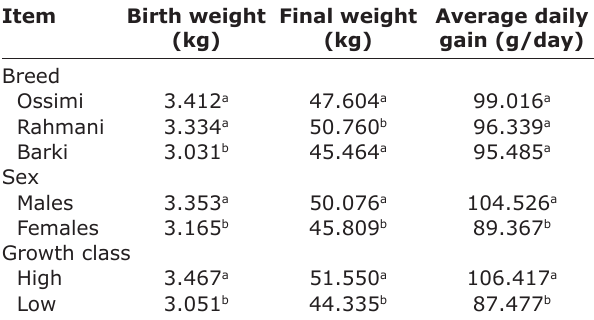
Table-2: Least squares means of birth weight, final weight, and average daily gain for Ossimi, Rahmani, and Barki sheep breeds.